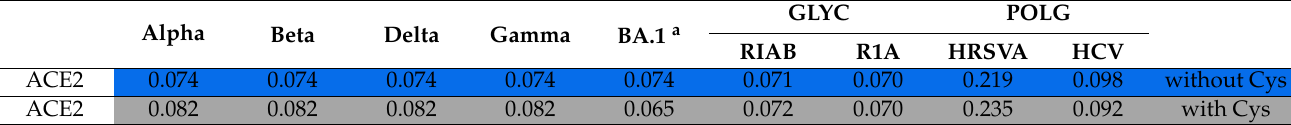
Table 2. The similarity between ACE2 and SARS-CoV-2 proteins (spike variants and polyproteins R1AB and R1A) was measured by the “average” method, based on whole amino acid content except Cys (without Cys) or based on complete amino acid content (with Cys). The scale of values goes from 1 (no similarity) to 0 (identical proteins). As a negative control, proteins from viruses that do not use ACE2 as a receptor were analyzed (glycoprotein G of human respiratory syncytial virus A and genome polyprotein of hepatitis C virus). Blue represents ACE2 in the analysis without Cys. Grey represents ACE2 in the analysis with